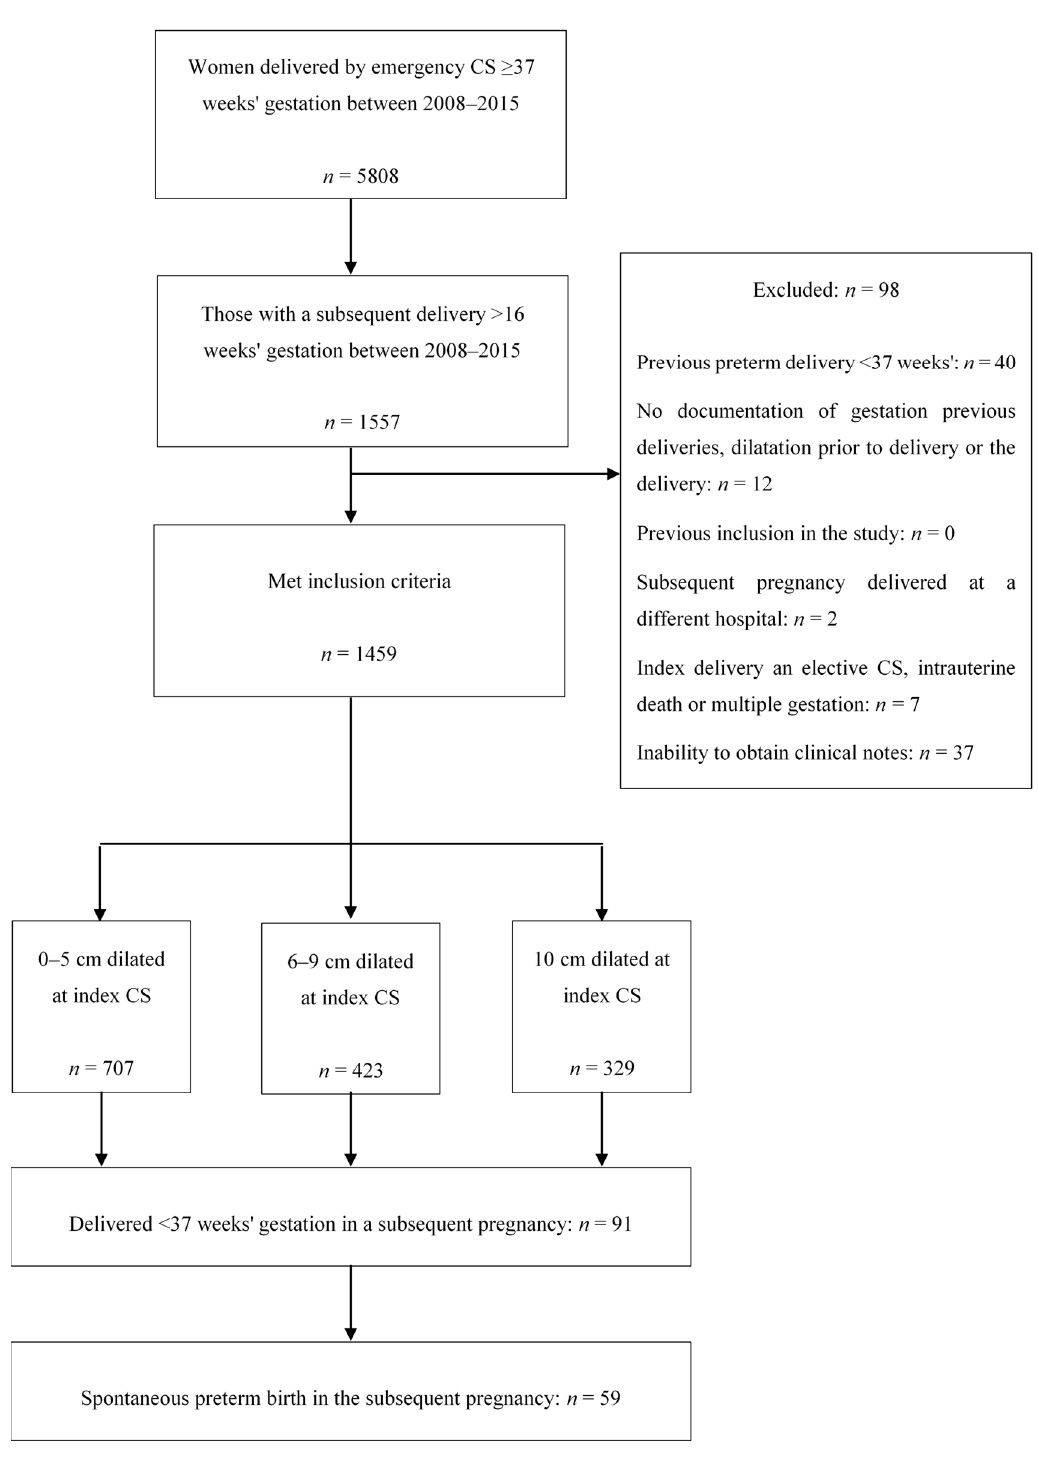
Figure 1. A flow diagram of the study population. CS: Caesarean section.